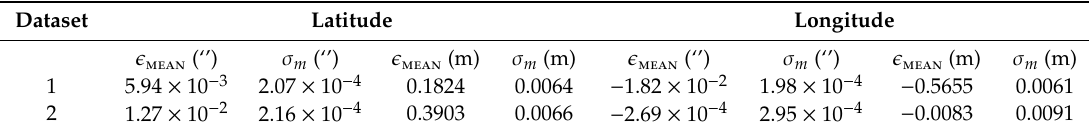
Table 5. Mean errors and standard deviation with the developed correction system